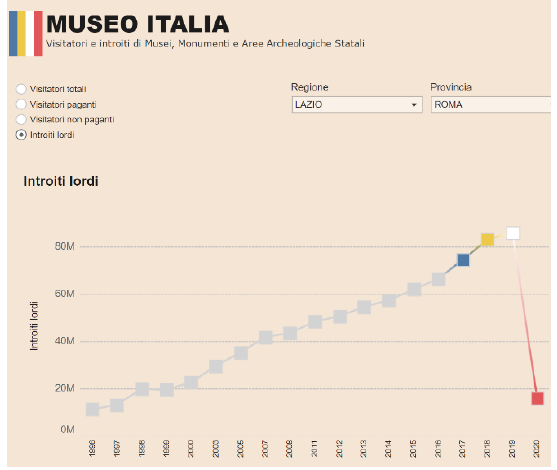
Figure 2. Visitors and income from museums, monuments and state archaeological sites: gross income from the Lazio region, the Province of Rome. Source: il Sole 24 Ore